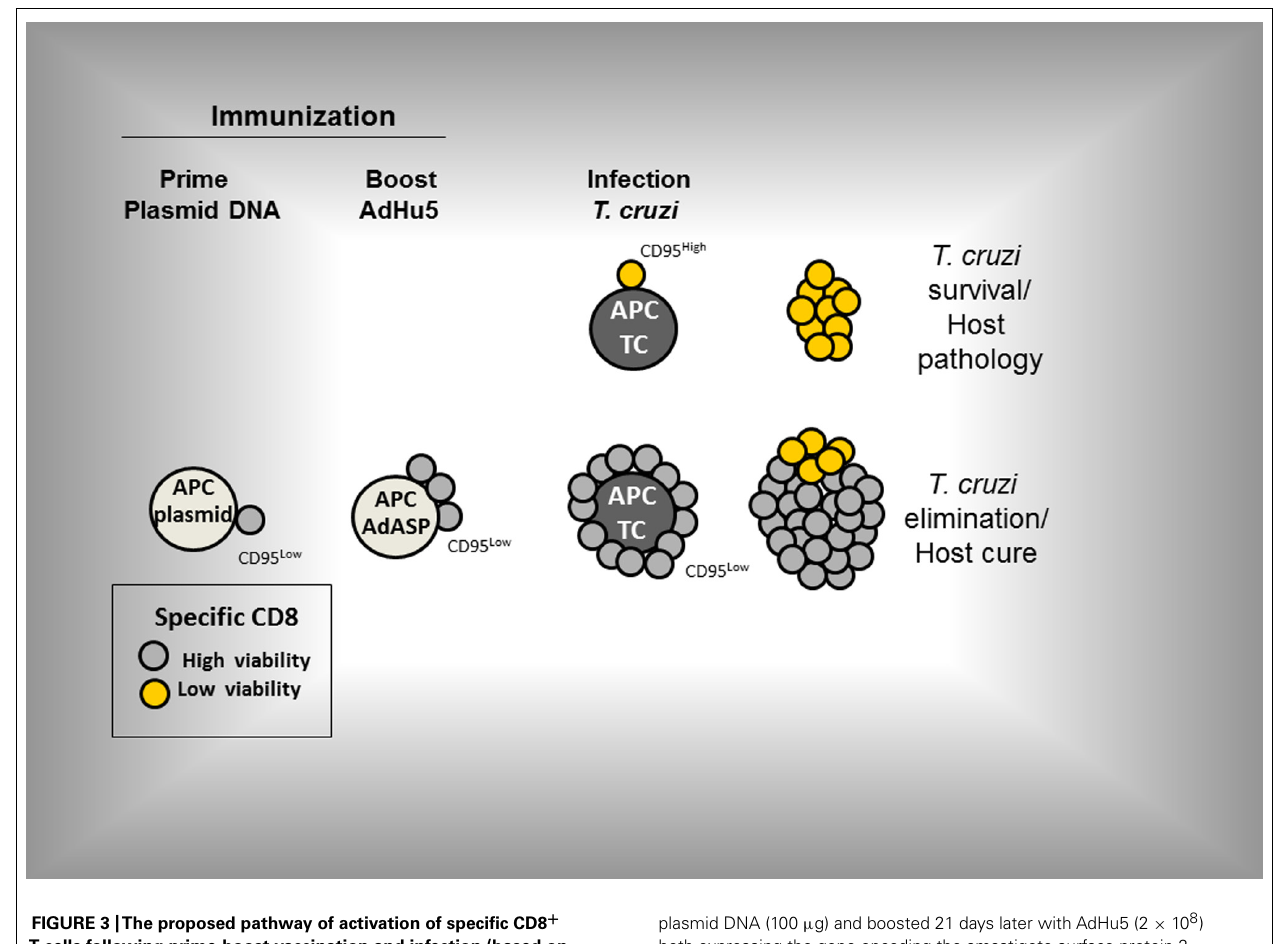
FIGURE 3 |The proposed pathway of activation of specific CD8 + T cells following prime-boost vaccination and infection (based on Vasconcelos etal., 2012). Prime-boost regimen was performed as detailed described by Rigato etal. (2011). Mice were primed i.m. with